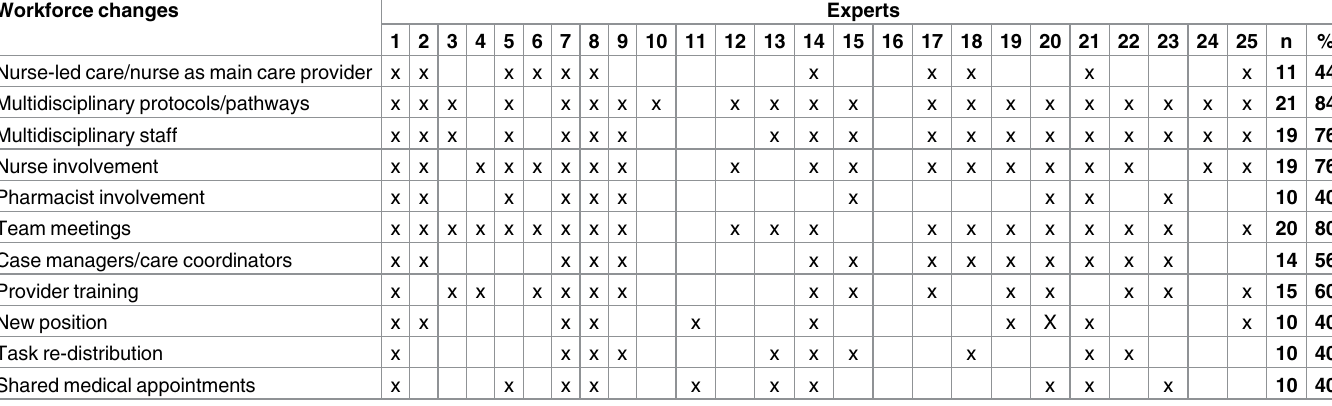
Table 5. Overview of the workforce changes confirmed by the questionnaire respondents and number and percentage of respondents confirming the respective changes.